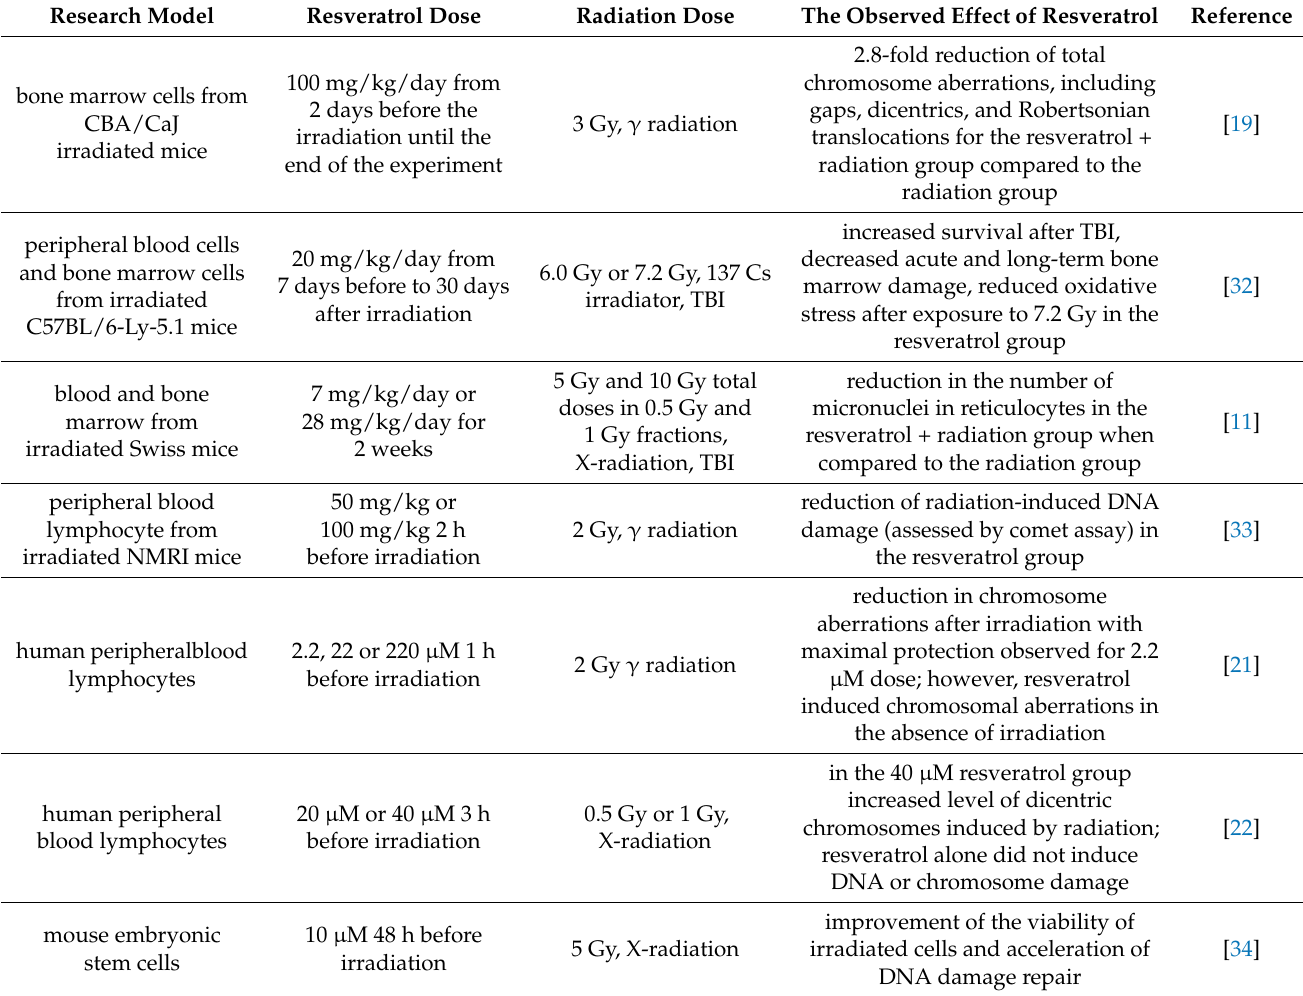
Table 1. An overview of studies on the radioprotective effects of